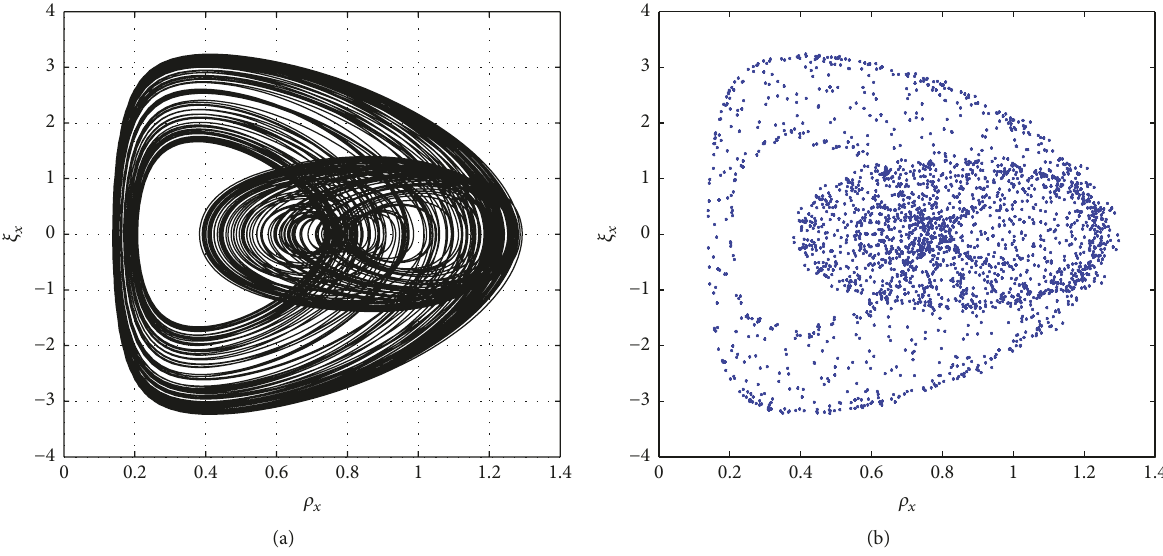
Figure 2: Phase portrait (a) and Poincar´e sections (b) in the plane 𝜉 𝑥 , 𝜌 𝑥 with the initial conditions 𝑞 𝑥𝑜 = 1 , 𝑞 𝑦𝑜 = 1 , 𝑝 𝑥𝑜 = 3 , 𝑝 𝑦𝑜 = 1 , 𝜌 𝑥𝑜 = 1 , 𝜌 = 1 , 𝜉 = 1 , and 𝜉 = 3 . We set the zero coupling parameters as 𝜅 = 3 and 𝛼 = 0.1 𝑦𝑜 𝑥𝑜 𝑦𝑜